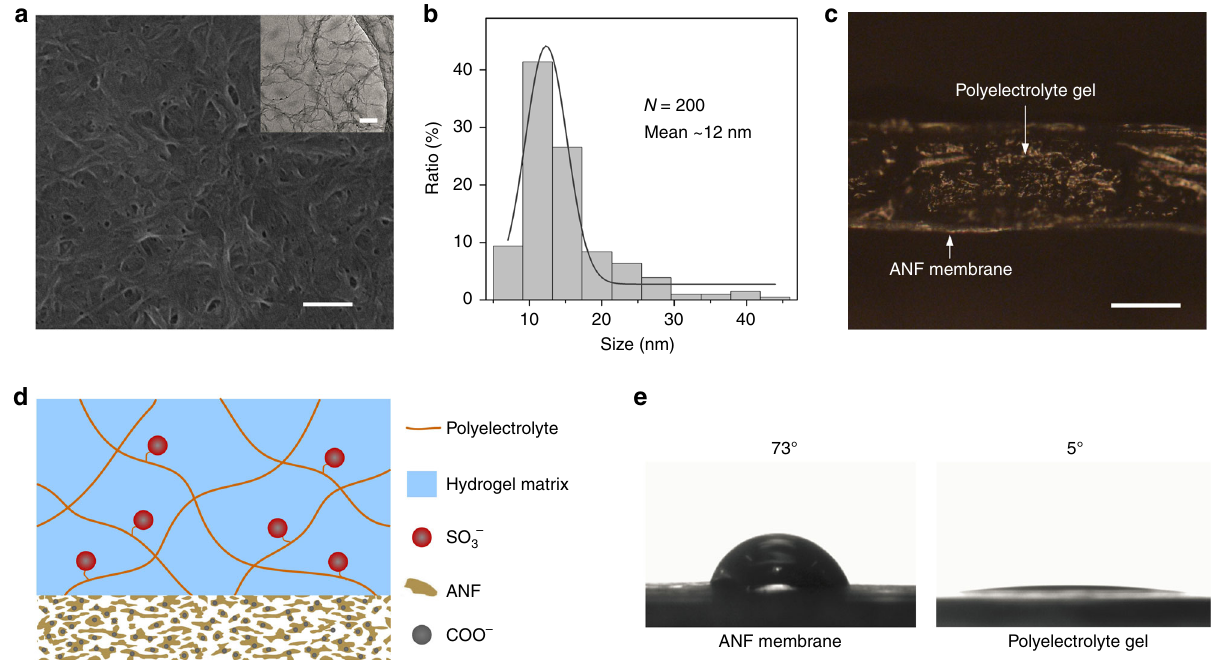
Fig. 2 Characterization of the heterogeneous membrane. a Surface SEM image of the ANF membrane (scale bar: 300 nm). The inset shows TEM image of the ANFs (scale bar: 250 nm). b Pore-size distribution of the ANF membrane obtained through data statistics of the SEM image (the gray line represents the Gauss fi t). c Photograph of the cross-section view of the ANF/gel heterogeneous membrane (scale bar: 100 μ m). d 2D cross-section illustration of the hybrid membrane featuring asymmetric structure and charge distribution. e Contact angle measurements of the ANF membrane and polyelectrolyte